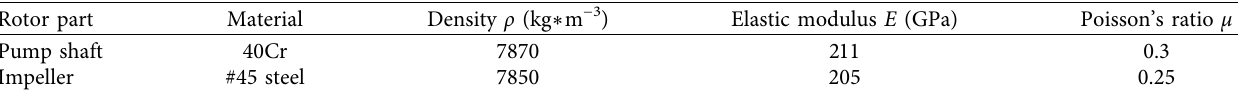
Table 4: Material properties.